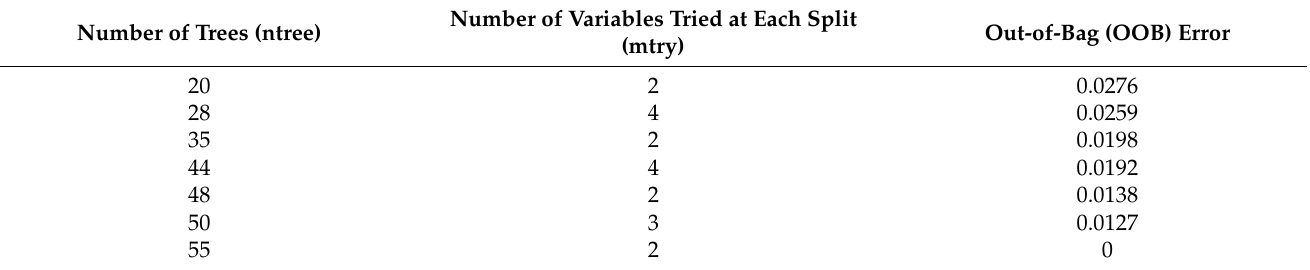
Table 3. Confusion matrix for the random forest algorithm for the LEWS.